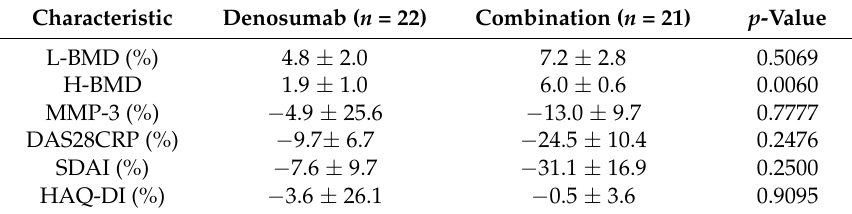
Table 3. Percent changes at 12 months of treatment. D ata are expressed as mean ± standard